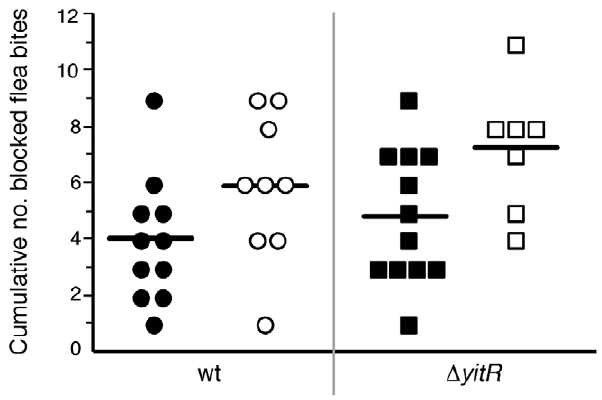
Figure 5. Mean and range of the cumulative number of blocked flea bites received by mice. Circles and squares indicate individual mice challenged by fleas infected with wt or D yitR Y. pestis 195/P, respectively. Filled symbols indicate mice that developed terminal plague; open symbols indicate mice that did not develop disease.